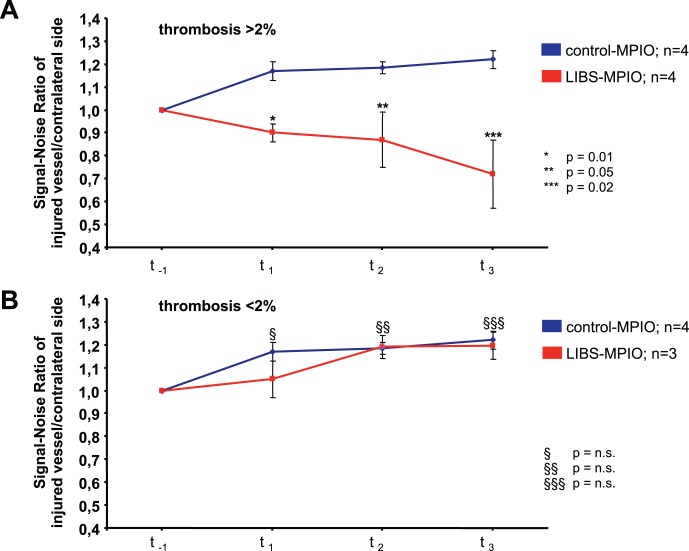
Quantitative analysis of MRI data.Subgroup analysis of animals with thrombus size >2% is shown in Fig. 3A for animals with LIBS-MPIO and control-MPIO injection. At each time point after the injection of LIBS-MPIO, the MR signal detected at the level of the scratched plaque was significantly lower than the signal detected at the contralateral and non-injured plaque level (A, red line). Conversely, the ratio of signals slightly increased after the injection of control-MPIO (A, blue line). In animals with thrombus size <2%, the signal ratio had not been altered by the injection of LIBS-MPIO in comparison to the injection of control-MPIO (3B).